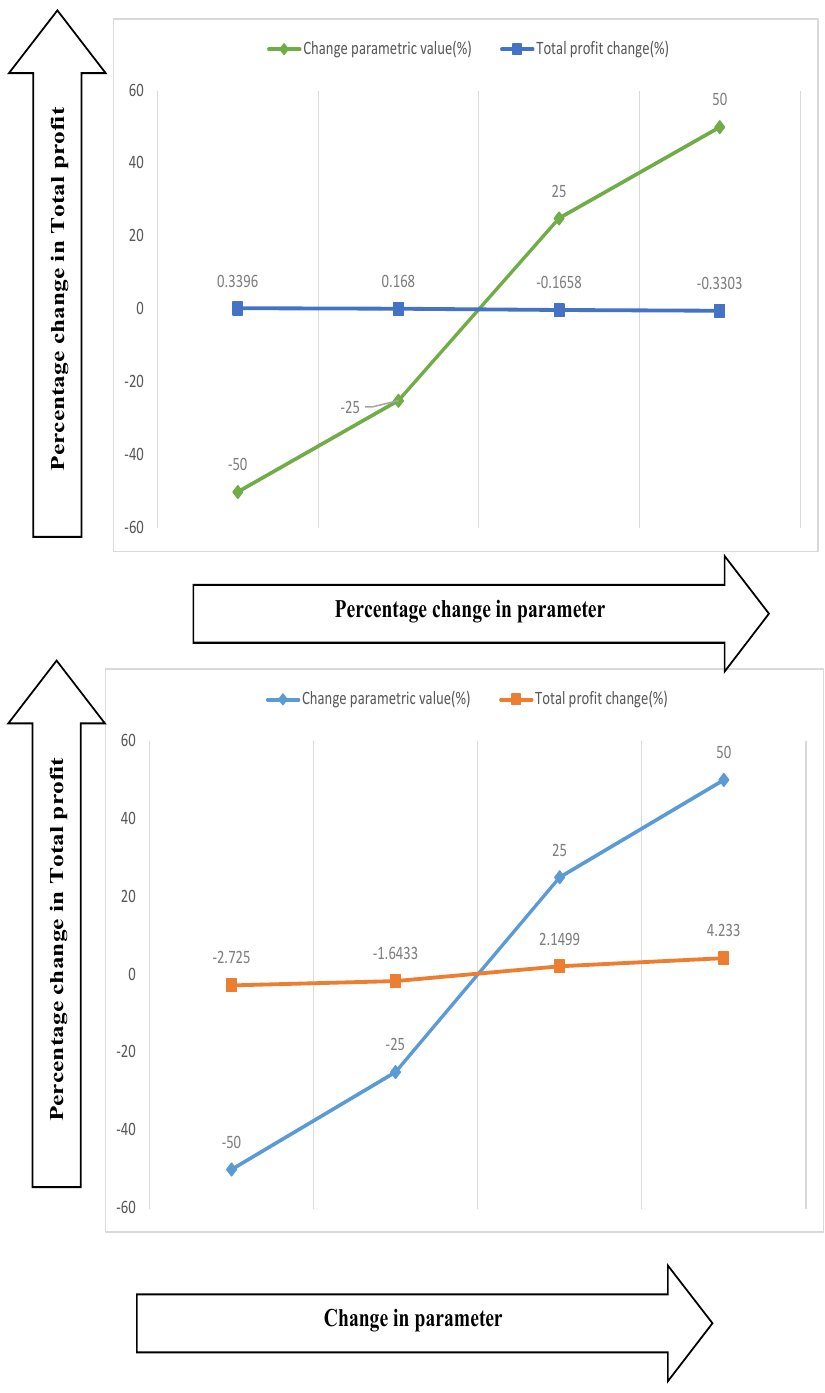
Figure 4. Changes in parameters P cv and M versus percentage change in total profit,